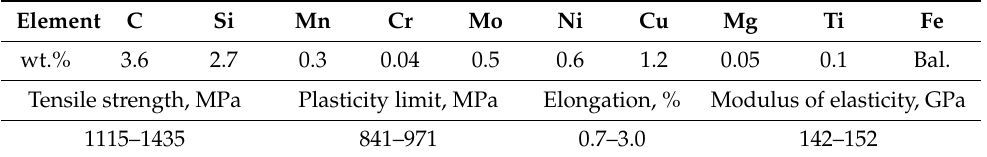
Table 1. Chemical composition in wt.% and characteristic mechanical properties of austempered ductile cast iron (adapted from [27] Technologija, 2019).